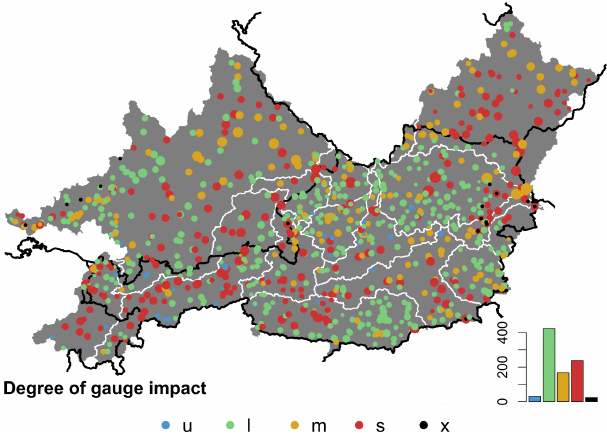
Figure 12. Degree of (anthropogenic) impact on gauges/catchments. The histogram indicates the number of gauges (out of 882) in each category. The size of the circles is proportional to the catchment area. Classes: u – no influence, l – low influence, m – moderate influence, s – strong influence, x – not considered in basin delineation. © EuroGeographics for the administrative